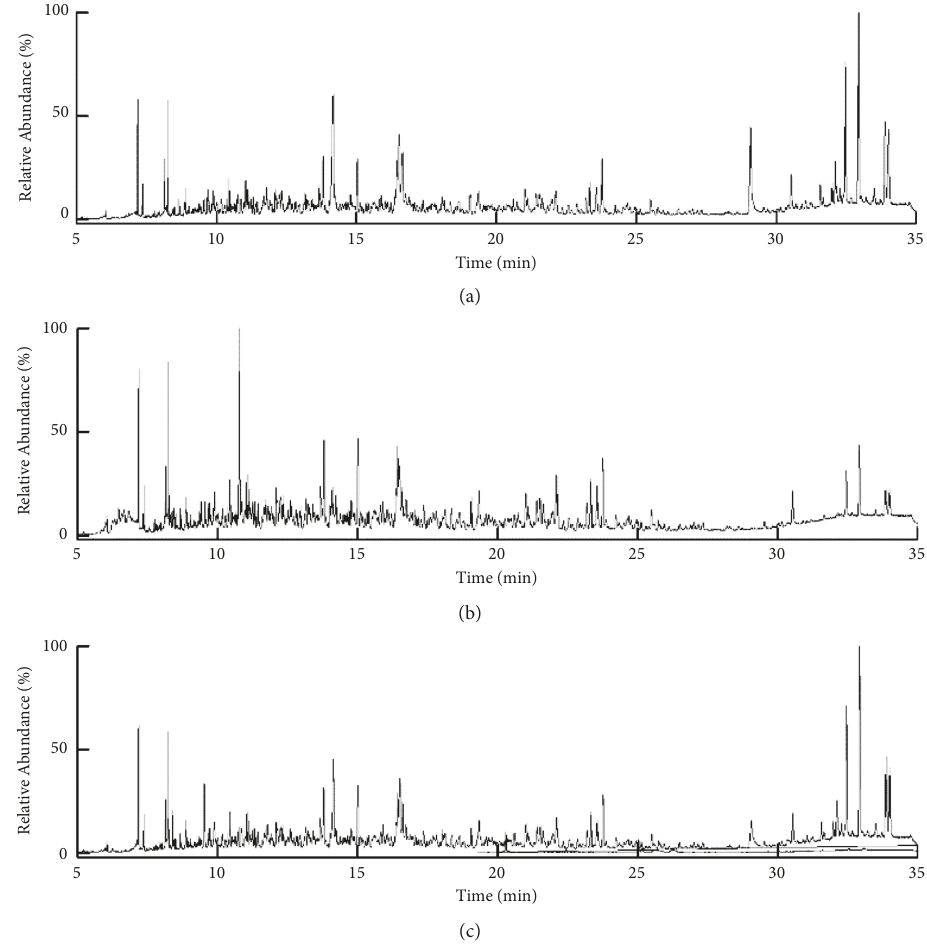
Figure 2: Total ion current chromatograms of the spiked (10 μ g · kg − 1 ) chrysanthemum flower samples cleaned up by different purification conditions. (a) QuEChERS purification (simple matrix), (b) QuEChERS purification (complex matrix), and (c) Sin-QuChERS Nano